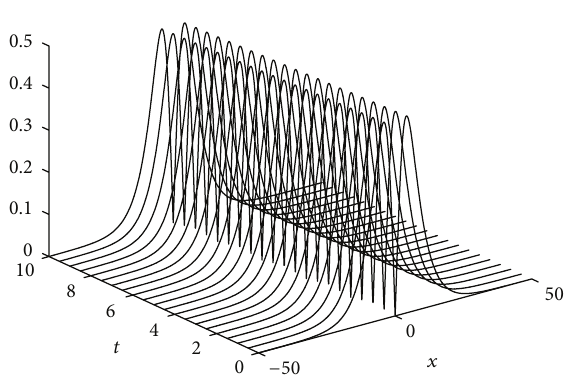
Figure 1: The evolution of the numerical solution of |𝑢| with 𝜖 = 1 .